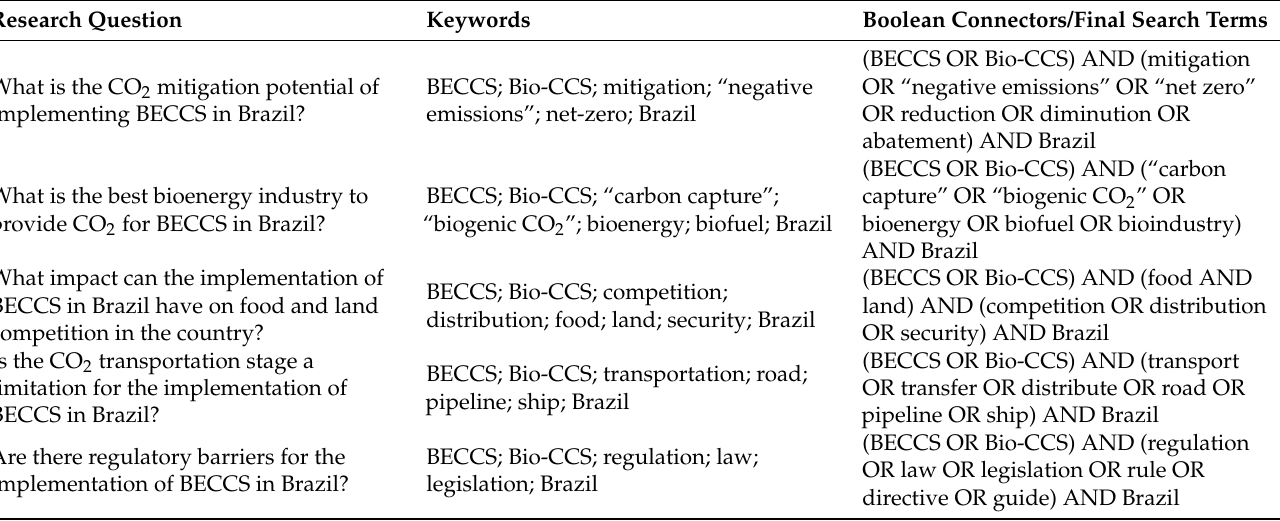
Table 2. Definition of search terms using Boolean